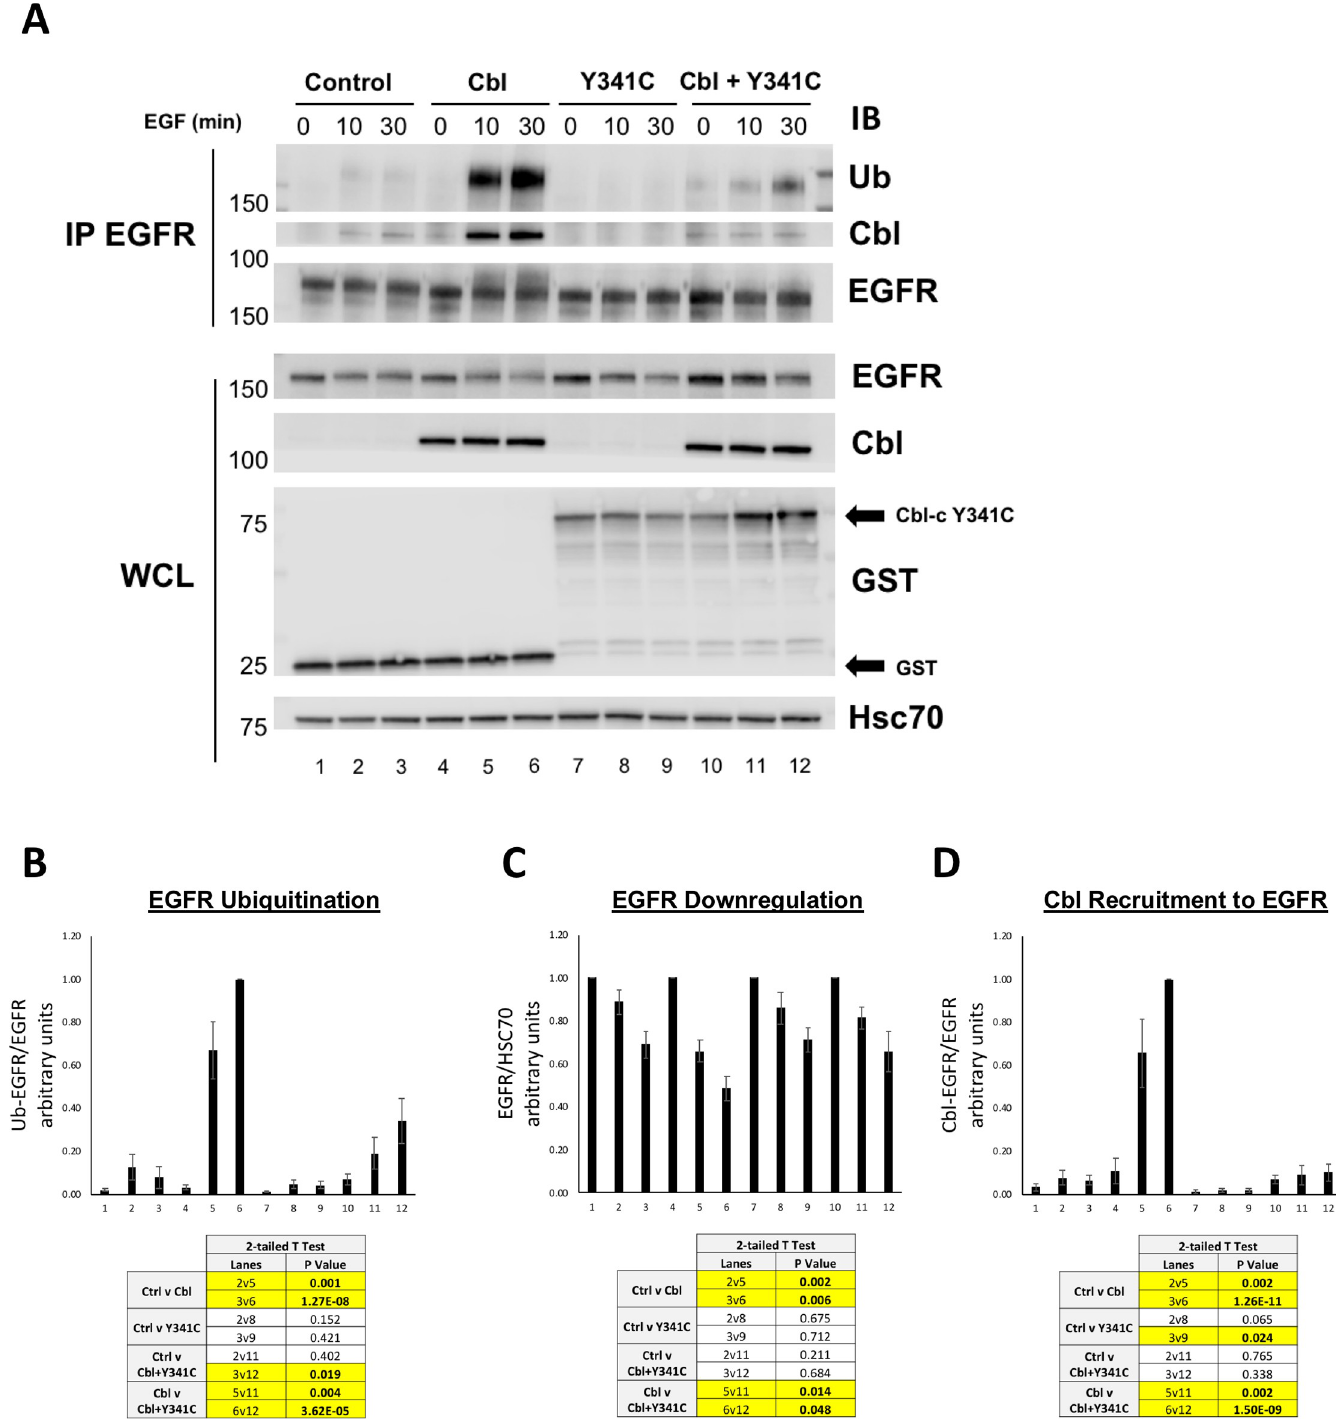
Fig 6. Cbl-c Y341C prevents ubiquitination and downregulation of EGFR by WT Cbl and blocks recruitment of Cbl to EGFR. ( A ) HEK 293T cells were transfected with GST (Control), WT Cbl, GST- Cbl-c Y341C, or a combination of WT Cbl and GST- Cbl-c Y341C along with EGFR. Cells were stimulated with EGF and lysates were harvested as previously described. Immunoprecipitated EGFR (IP: EGFR) and whole cell lysate (WCL) were probed for proteins as indicated. ( B ) Ubiquitination of the activated EGFR was quantified and normalized to total EGFR ( C ) EGFR levels were quantified from the WCL and normalized to Hsc70. ( D ) EGFR-associated Cbl was quantified and normalized to total EGFR (IP: EGFR). Graphs represent the average of 6 experiments +/- SE. p-values for relevant comparisons are shown in the tables accompanying the graphs. Significant comparisons (p � 0.05) are highlighted in yellow.